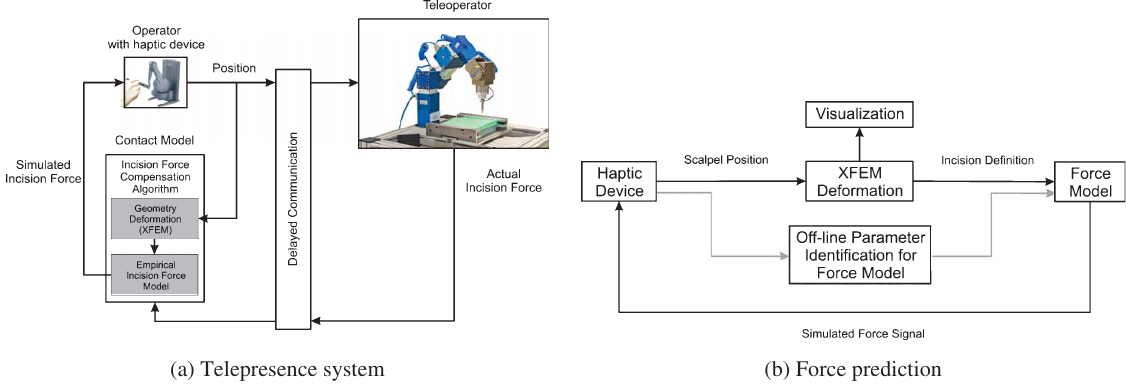
Fig. 7. (a) Depicts the telepresence system with time-delay compensation using real-time force prediction. (b) shows the diagram for the force prediction algorithm utilizing XFEM simulation and the incision force